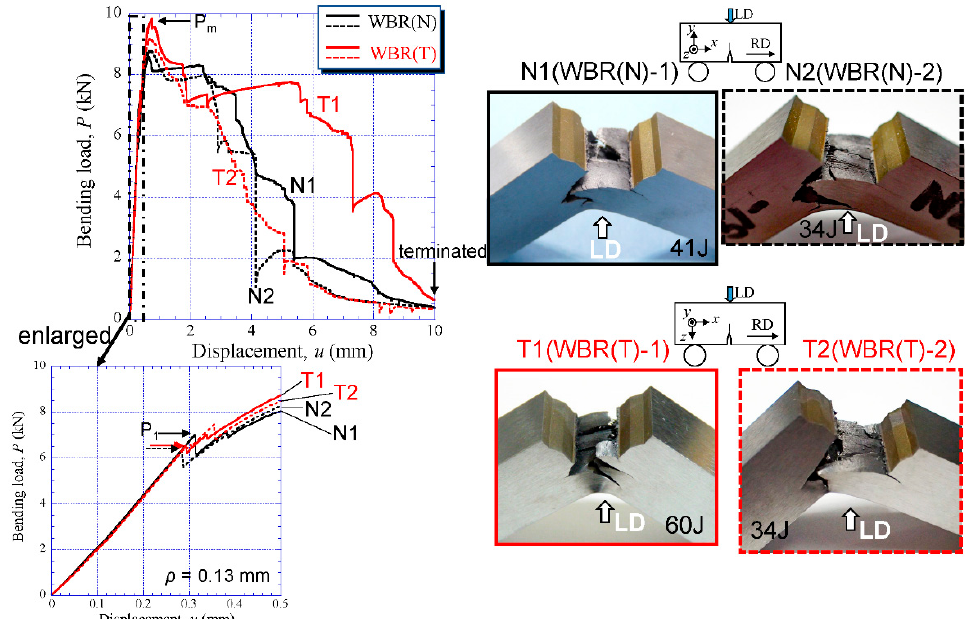
Figure 9. The P - u relations in the WBR(N) specimen and the WBR(T) specimen, and the appearance of the specimen.